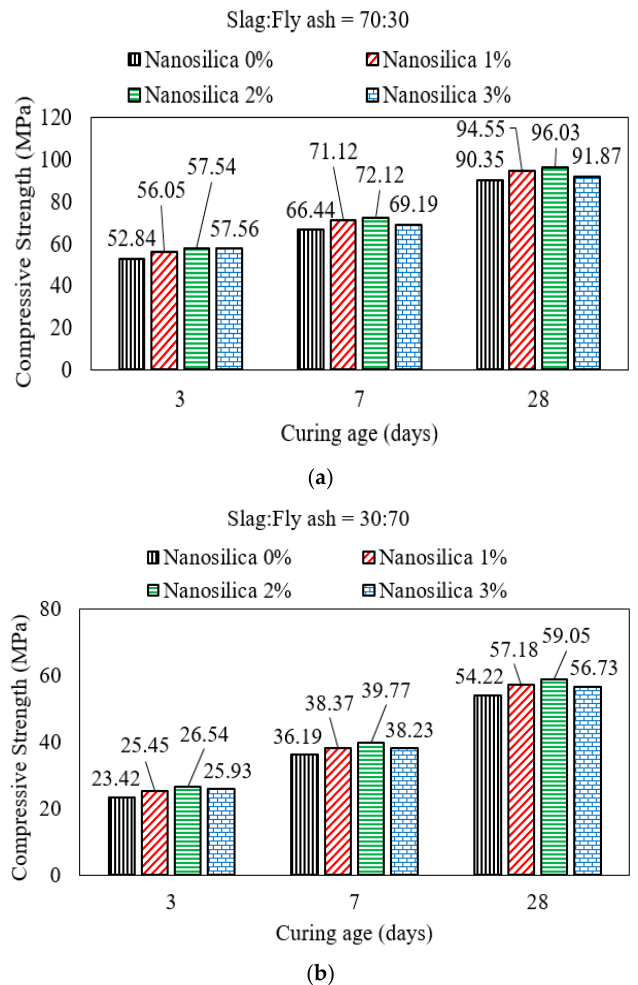
Figure 10. Compressive strength of mortar with AASF slag/fly ash blends. The ratio of slag:fly ash is ( a ) 70:30, ( b ) 30:70 [27].